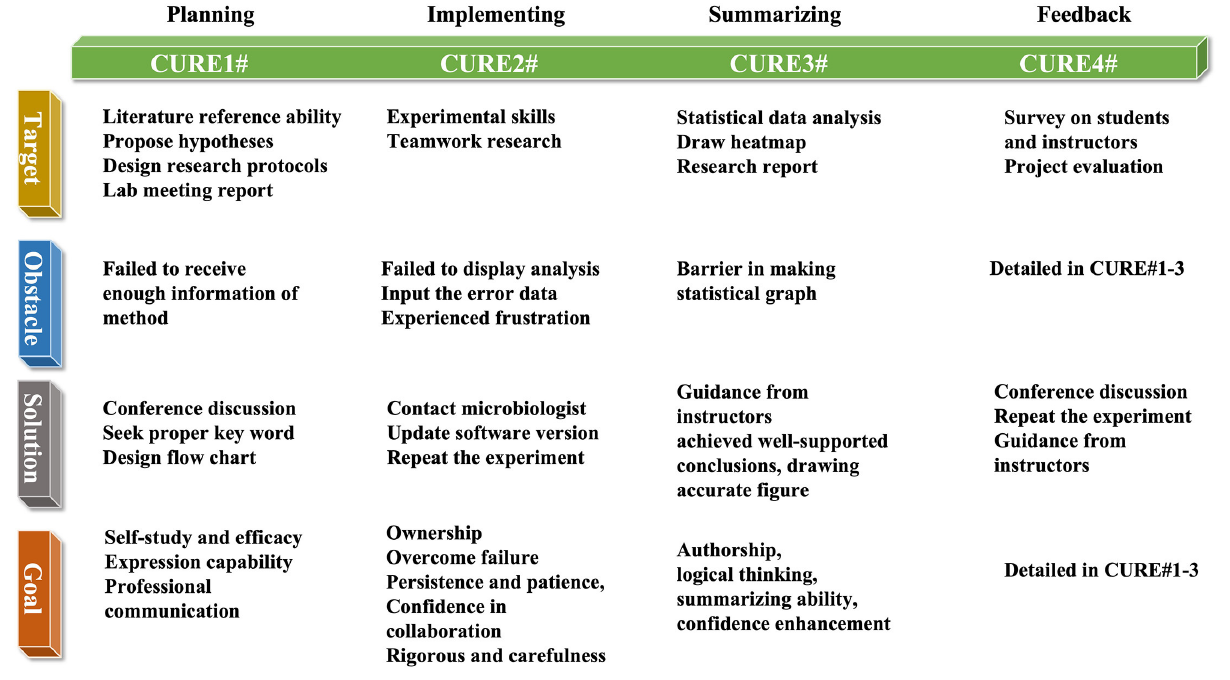
obstacle, solution and goal student reach was displayed in Figure 2